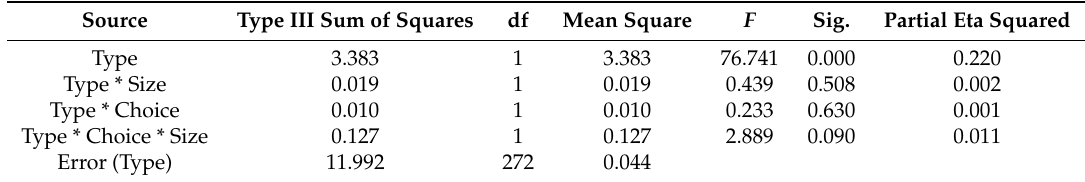
Table 5. Tests of within-subject effects for type of problem in respect of size and choice.